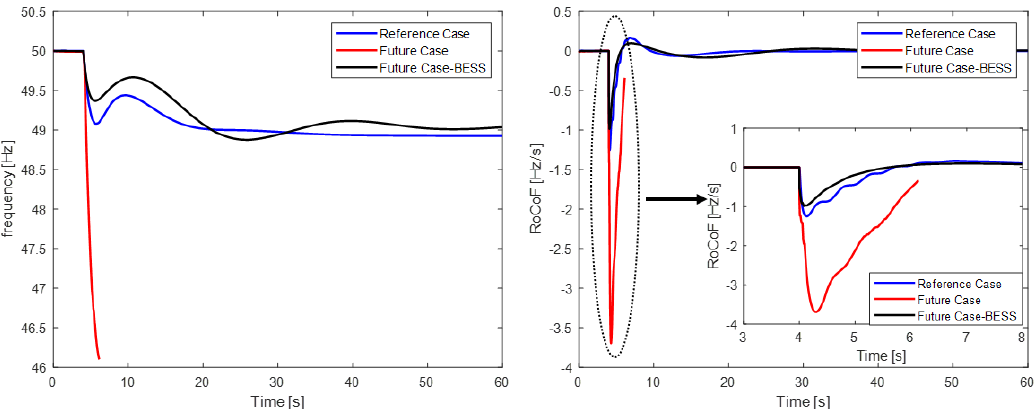
Figure 15. Generation loss frequency response and RoCoF for the worst cases for the reference, future and future with BESS scenarios.